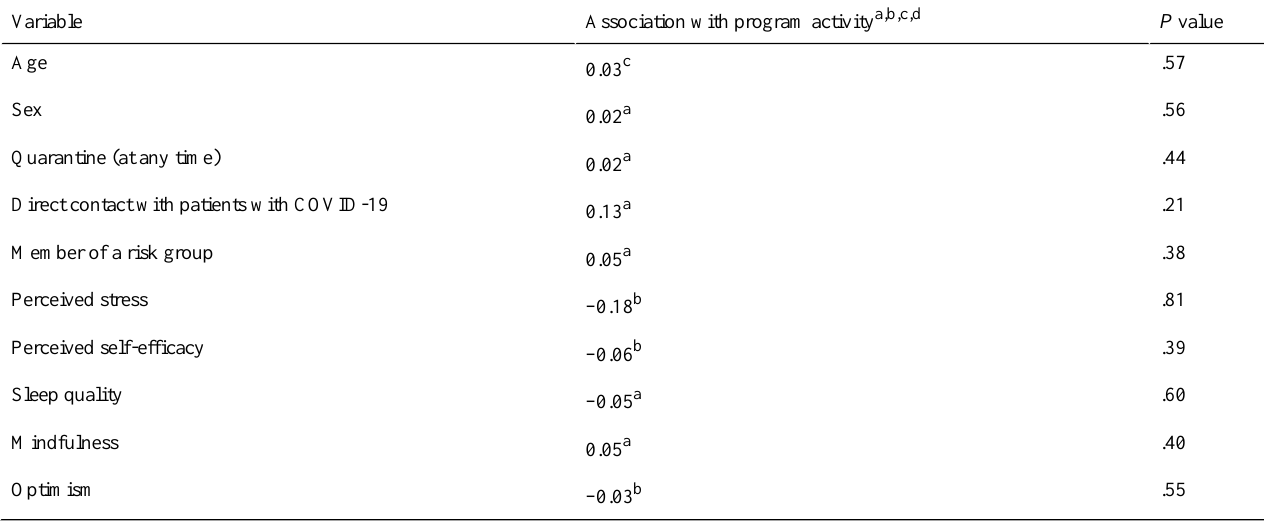
Table 2. Association between program activity levels (ie, click count score) and sociodemographic variables, perceived stress, and scores mapping on module